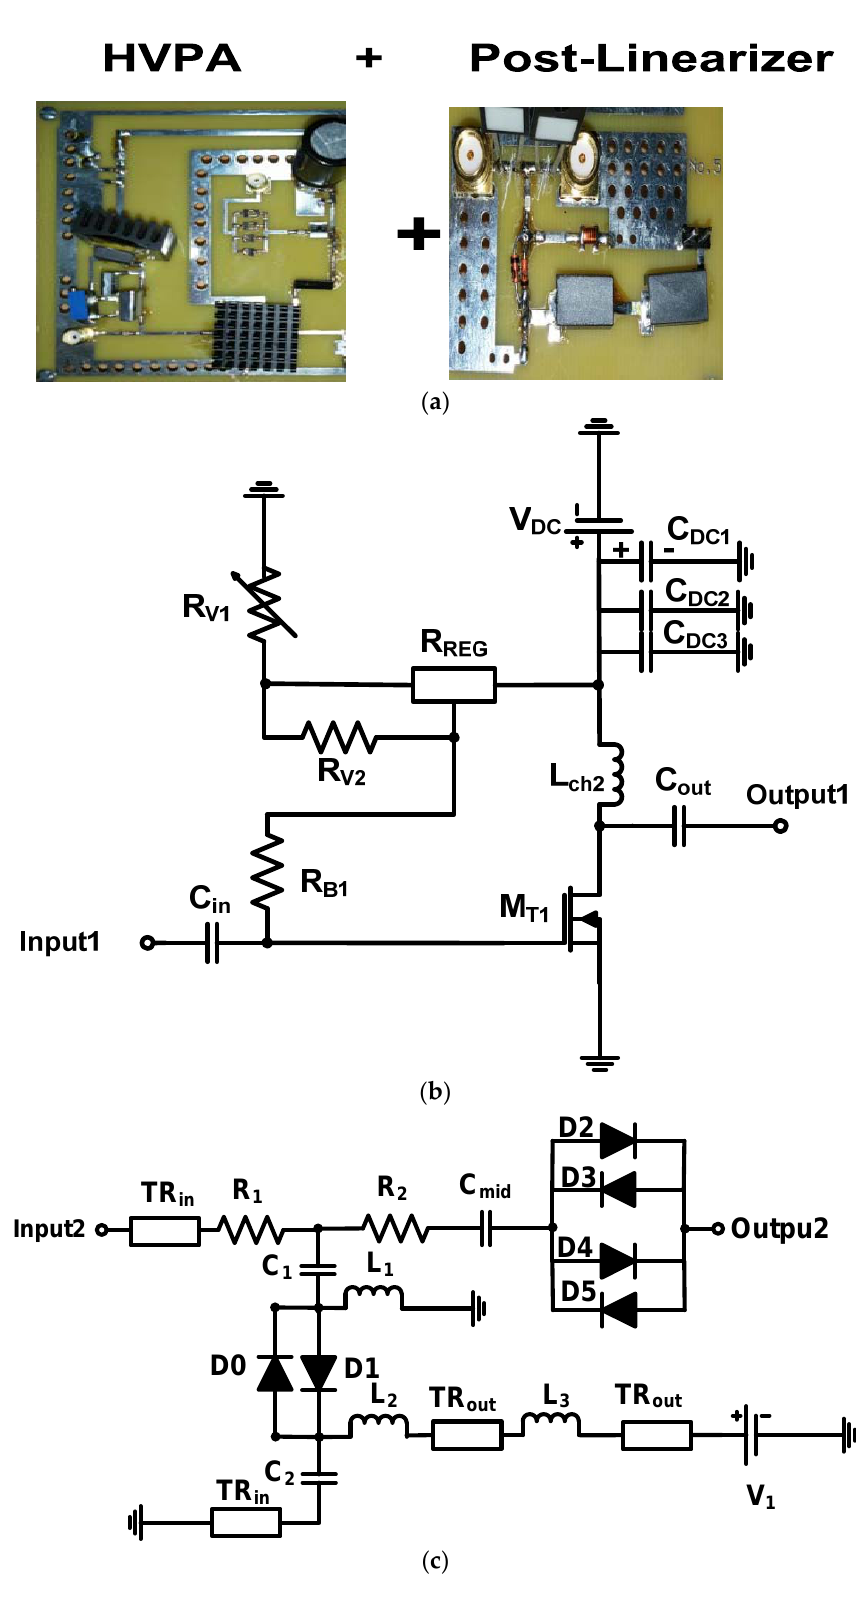
Figure 2. Block diagram and schematics of the HVPA and post ‐ linearizer: ( a ) Implementation of the HVPA and post ‐ linearizer, Schematics of the ( b ) HVPA, and ( c ) post ‐ linearizer.